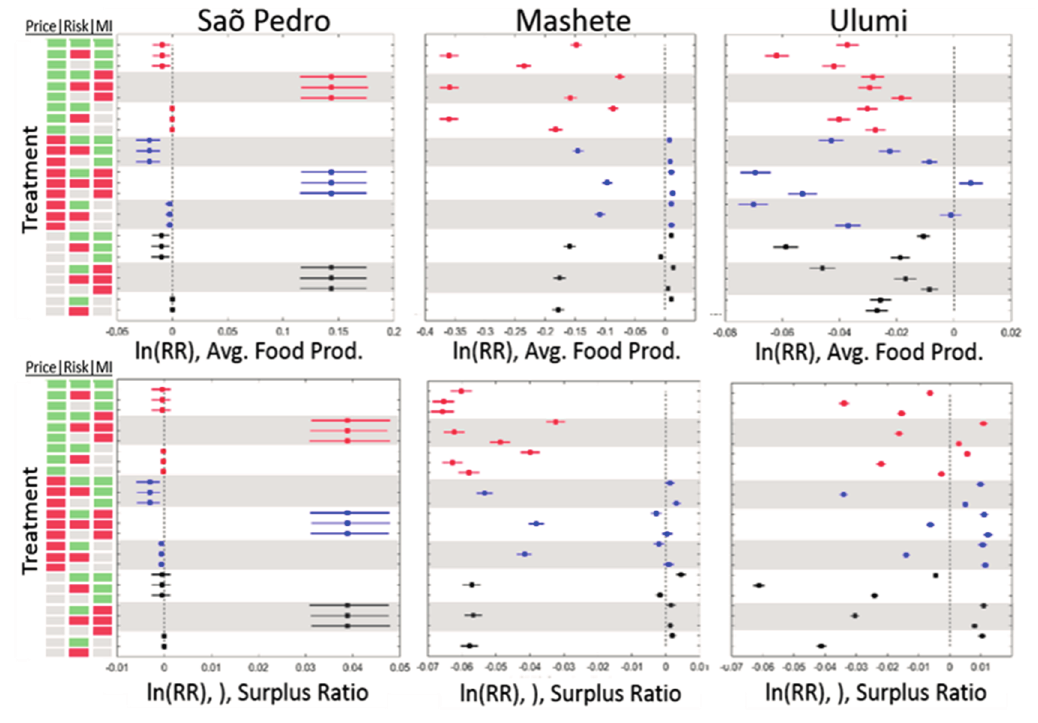
Figure 8. Mean effect sizes of experimental treatments on average food production and surplus ratio ( i.e. , food production relative to subsistence needs). Experimental treatments are indicated in the color-coded panels on the far left and are displayed as combinations of commodity price (left column), average risk preference (middle column), and market influence (MI, right column) perturbations. Green, gray, and red treatment cells indicate increased, baseline, and decreased treatment values, respectively. Effect sizes are plotted with the mean and 95% confidence interval. Interpretation . Effect sizes are significant at α =0.05 level when intervals do not include zero or do not overlap between categories [73,74]. Within each plot, effect sizes are grouped and colored by commodity price level (red points = higher prices; blue points = lower prices; black points = baseline prices). White and gray bands group experimental treatments by market influence settings. Thus, the relative influence of risk preferences is shown by the amount of horizontal dispersion of points within a white/gray